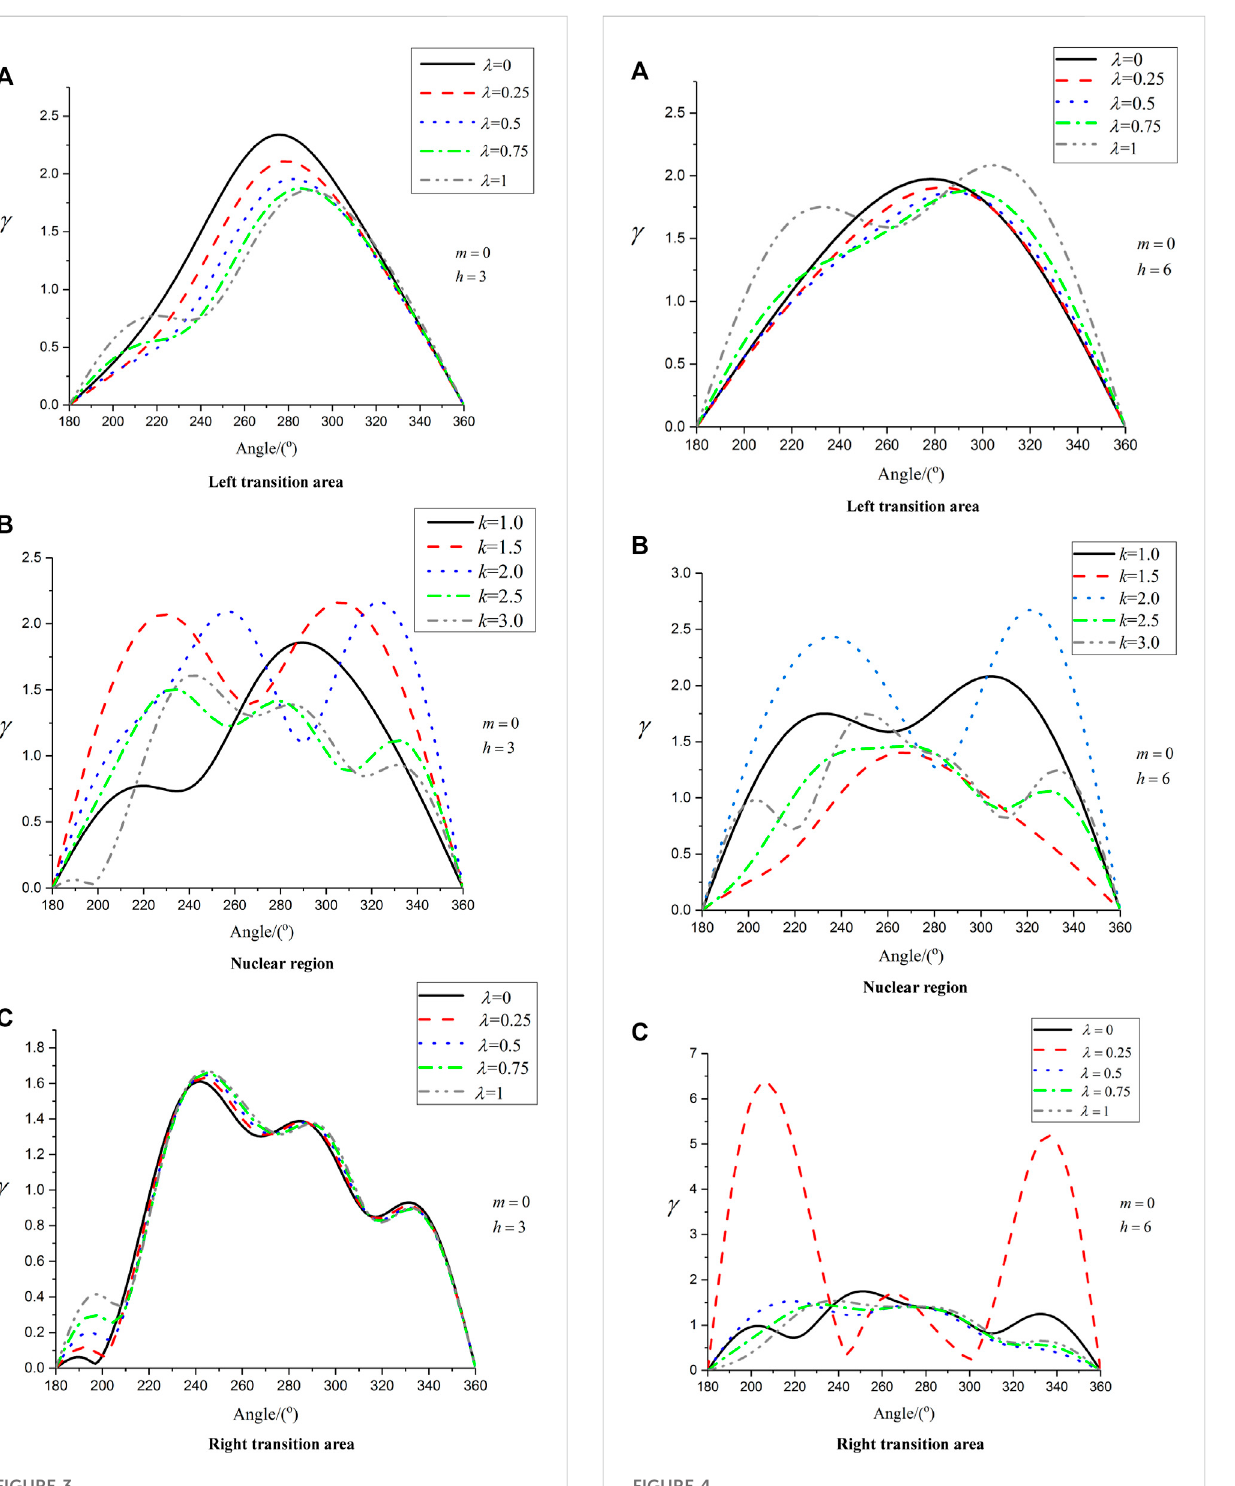
FIGURE 3 Distribution of hoop dynamic stress concentration factor of semi- circular depression when the thickness of the ribbon domain is h (cid:2) 3. (A – C) represent the results of these three subsets: Left transition area, Nuclear region and Right transition area.